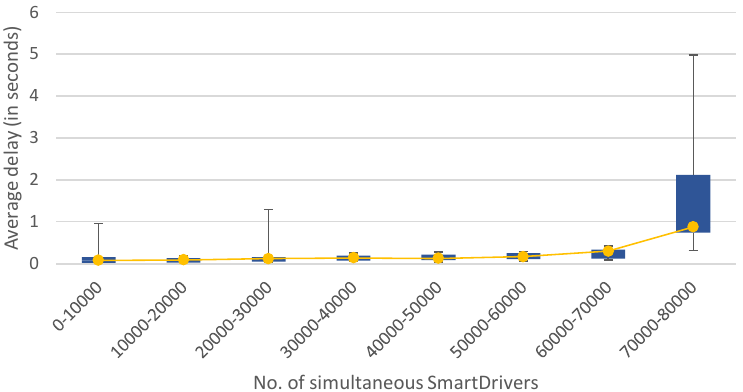
Figure 8. Number of simultaneous drivers that can be served and response delay for one centralised- cloud FIWARE server (see [53] for more details). The timeout threshold considered is 5 s.